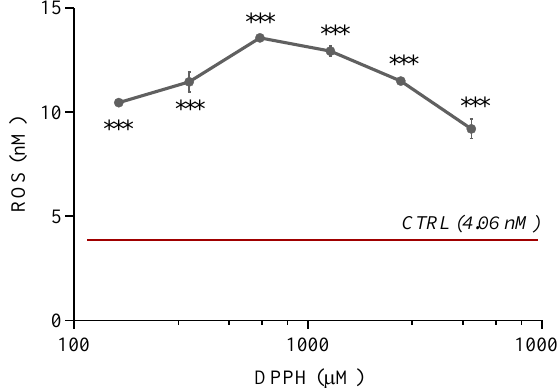
Figure 4. ROS concentration (expressed in nM) in PNT2 cells treated with DPPH. Cells were treated with 156, 312, 625, 1250, 2500 and 5000 µM for 6 h and the resulting cell lysate was analysed with a plate reader (Ex: 480 nm, Em: 530 nm). The red bar represents the ROS basal level in untreated PNT2 (control, CTRL). The values reported are the mean ± SD of three independent experiments. Asterisks indicate the statistically significant difference compared to the control (*** p ≤ 0.001; Dunnett’s test).